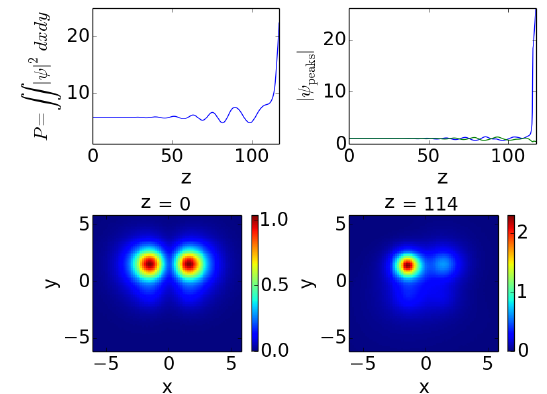
Figure 6. This figure is similar to Figure 5 (the final evolution distance however is about z = 114). Here, the plots correspond to the time evolution of the branch 2 solution for the value µ ≈ 0.94. In the top right plot, the blue curve corresponds to the left peak of the magnitude of the solution over z and the green corresponds to the right peak of the magnitude.